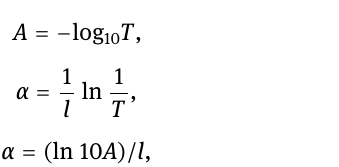
Figure 1: A simpli fi ed schematic diagram illustrating the whole synthesis process of PMMA –